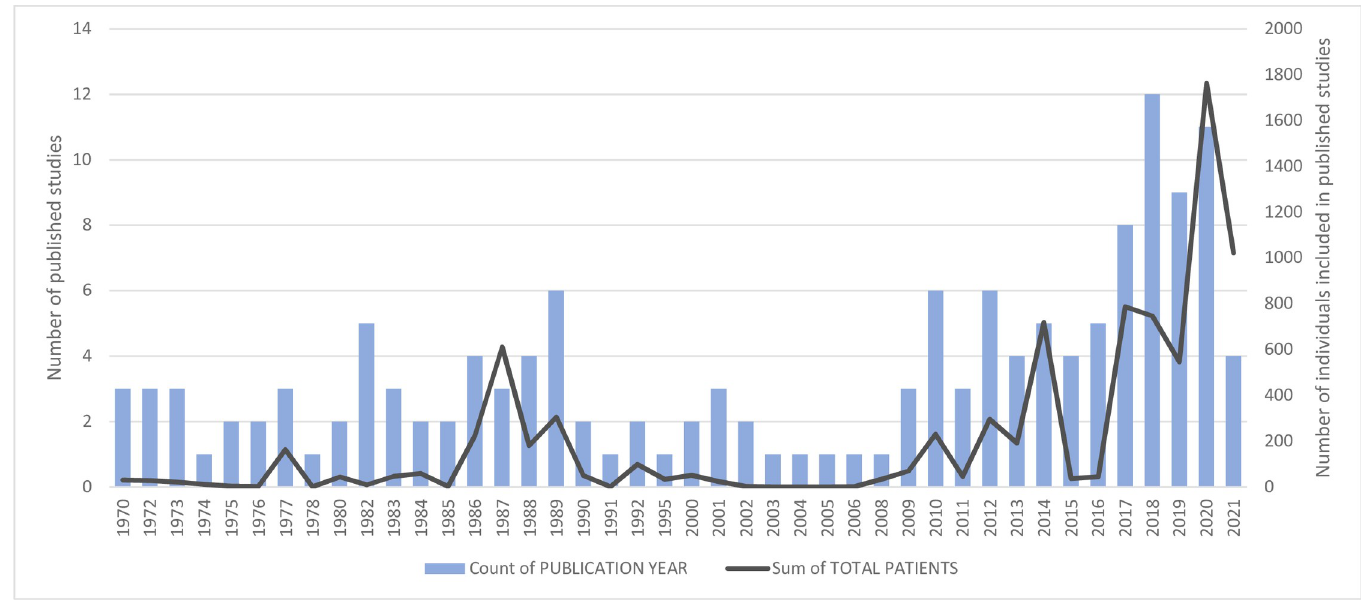
Fig 2. Number of Lassa fever clinical studies published per